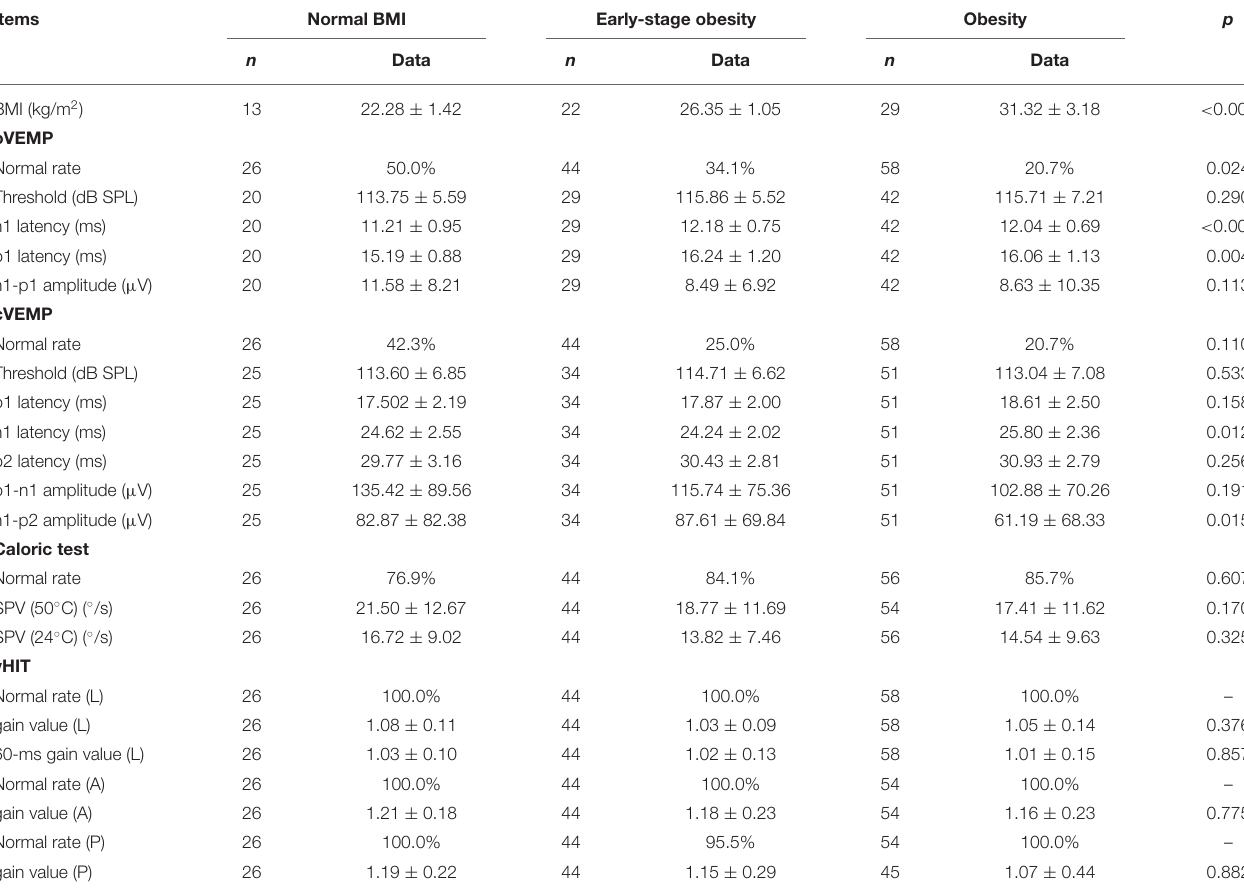
TABLE 4 | The normal rates and parameters of VEMPs, Caloric test, and vHIT in OSA patients with different degrees of BMI.